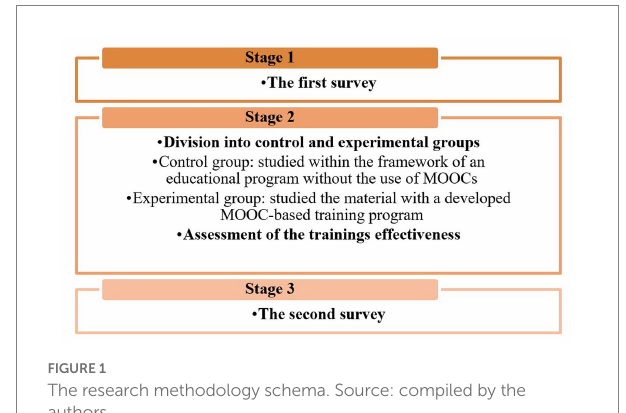
FIGURE 1 The research methodology schema. Source: compiled by the